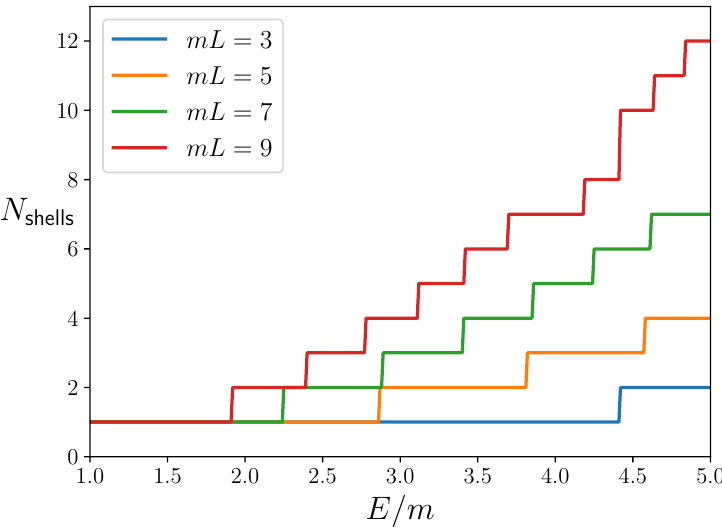
Figure 1. Number of active momentum shells for (cid:12)xed mL as a function of E